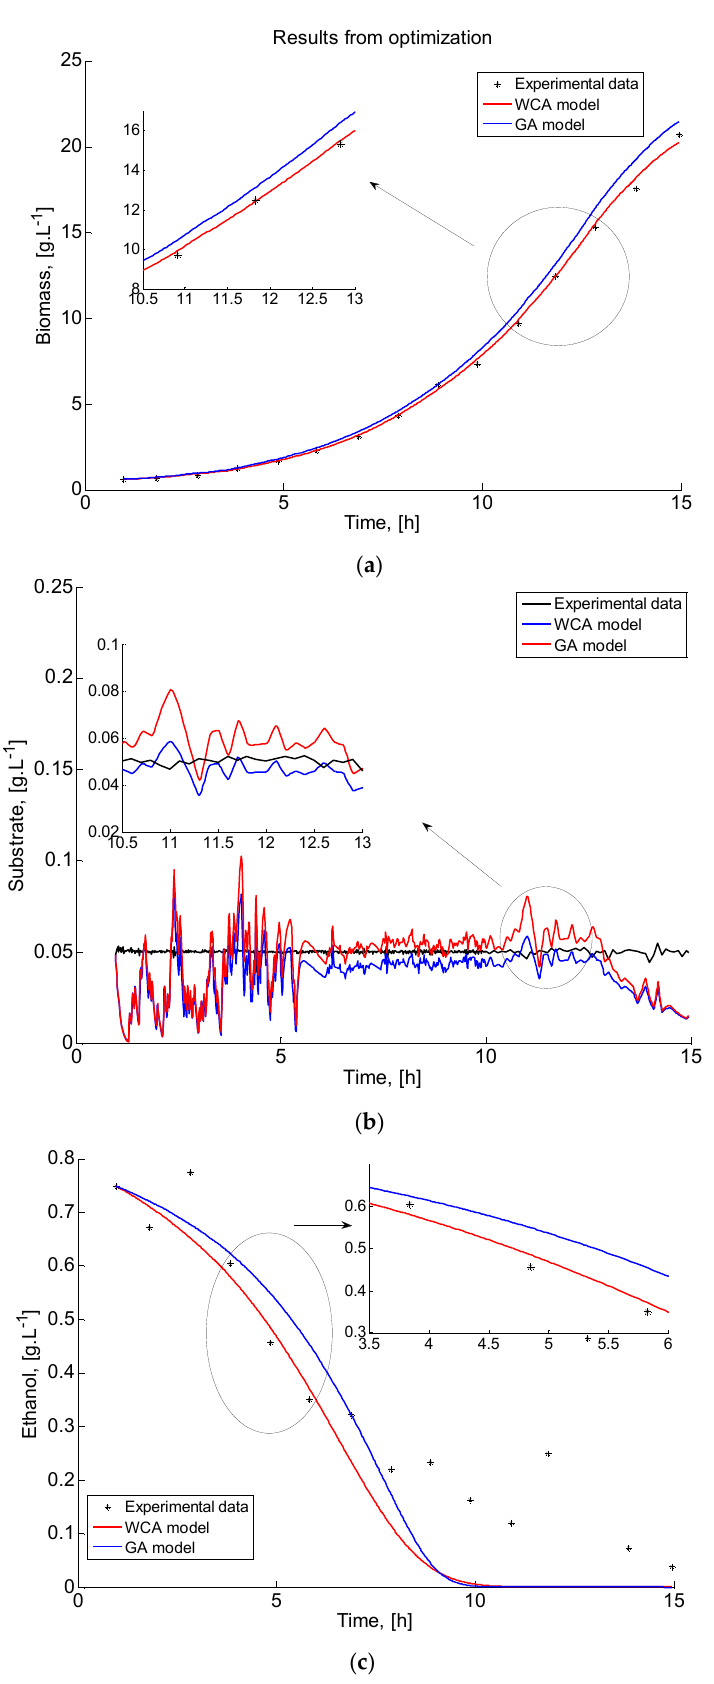
Figure 8. Case study 2 : comparison of the process variables time profiles obtained by GA and WCA: ( a ) biomass; ( b ) substrate; ( c ) ethanol.